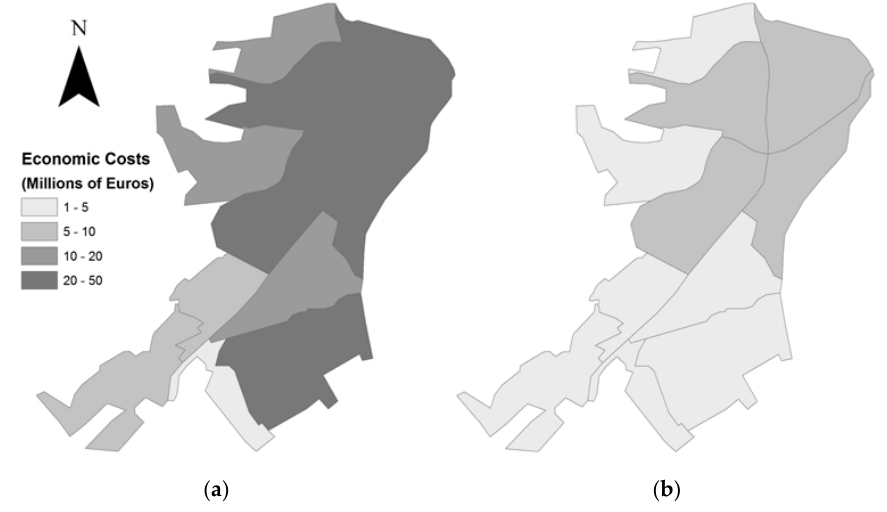
Figure 13. Distribution of economic cost according to ( a ) the deterministic scenario and ( b ) the probabilistic scenario.